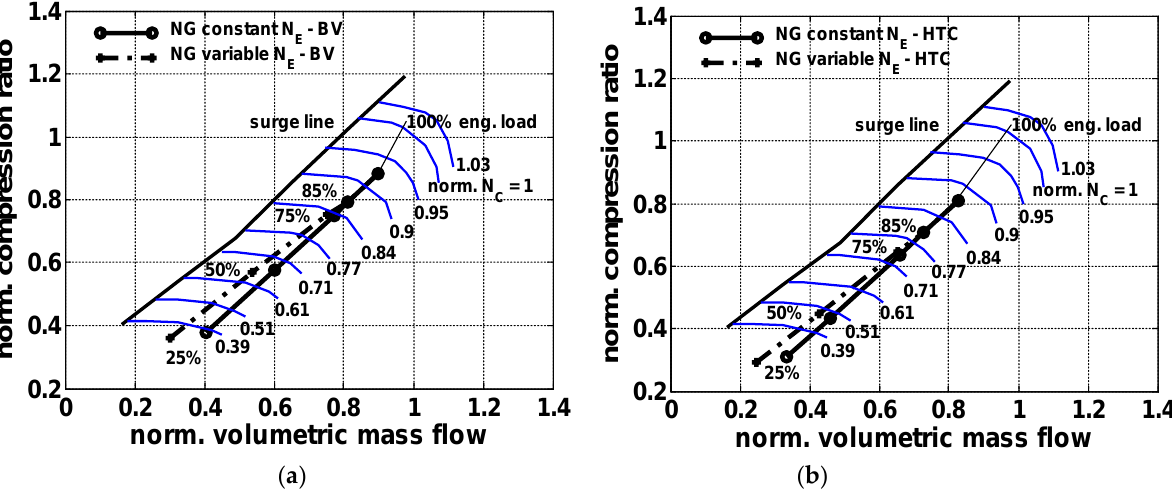
Figure 8. Working points in the compressor map for the NG-powered engine, equipped with original TC ( a ) and HTC ( b ), at constant and variable engine speeds N E .